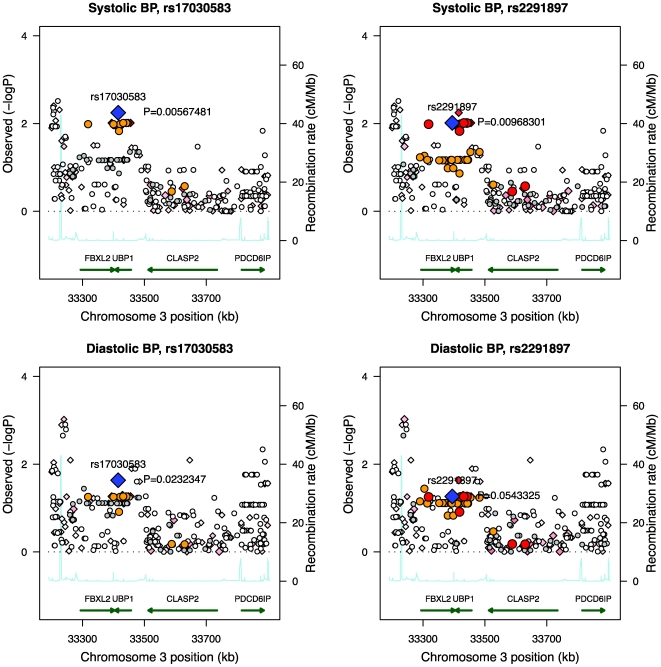
Regional association plots of the genomic location indicated by the mouse model in the EUGENE2 human study population.Associations of SNPs rs17030583 and rs2291897 (blue diamonds) to systolic and diastolic blood pressure are plotted with their P-values (as −log10 values) as a function of genomic position (with NCBI build 36). Estimated recombination rates (from Hapmap Phase 3) are plotted to reflect the local LD structure around the associated SNPs and their correlated proxies (red: r2≥0.8; orange: 0.5≤r2<0.8; gray: 0.2≤r2<0.5; white: r2<0.2). Diamonds represent directly genotyped markers and circles represent imputed markers.